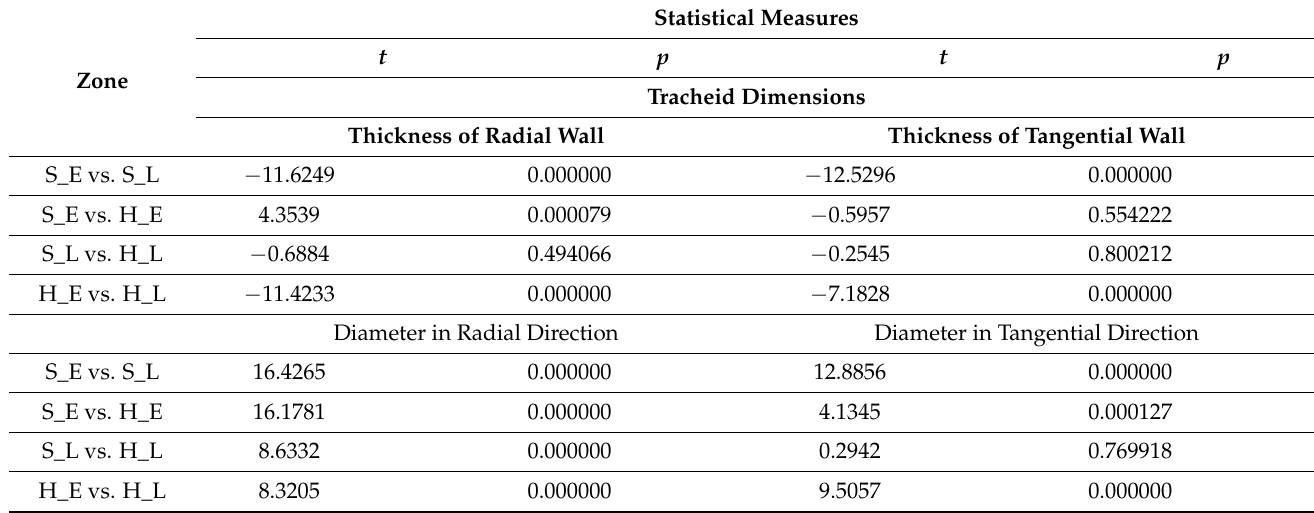
Table 2. Statistical analysis of the significance of the differences between the studied dimensions of oriental arborvitae wood ( t -test, p ≤